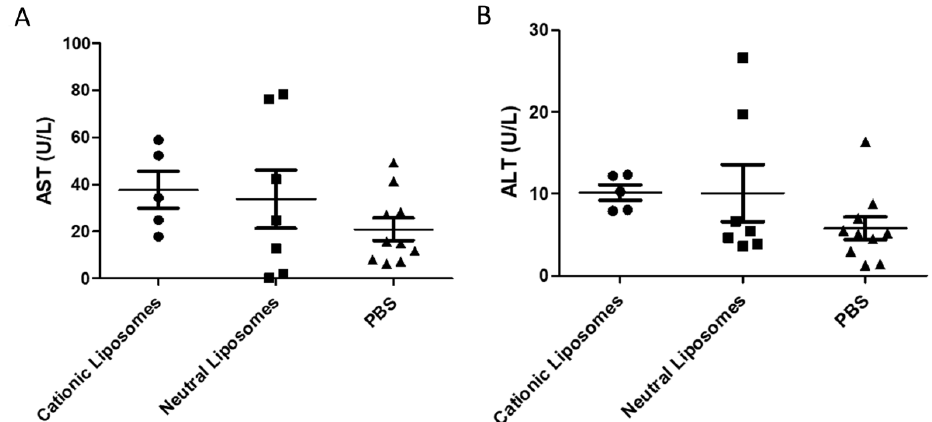
Figure 8. Plasma levels of ( A ) AST and ( B ) ALT in the blood of mice treated with either PBS (triangles), neutral (squares), or cationic liposomes (circles).